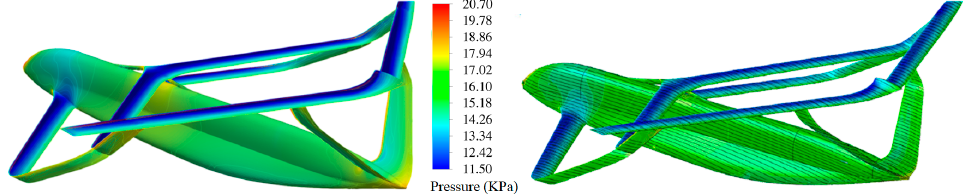
Figure 16. BWA/SL aircraft in cruise flight condition S 3 (M = 0.7 at 43,000 ft) with an angle-of-attack α = 0°. Absolute pressure distribution on the aircraft skin. Comparison between the current ( left ) and the alternative ( right ) simulations.